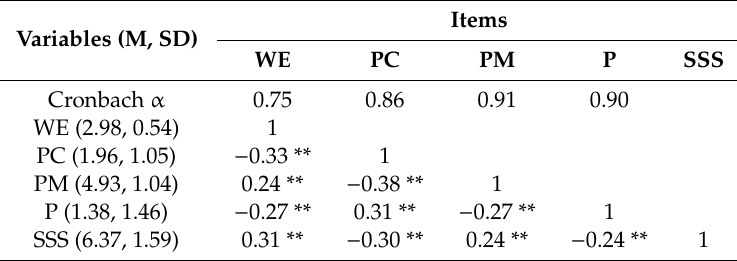
Table 3. Mean, standard deviation, and correlations among study